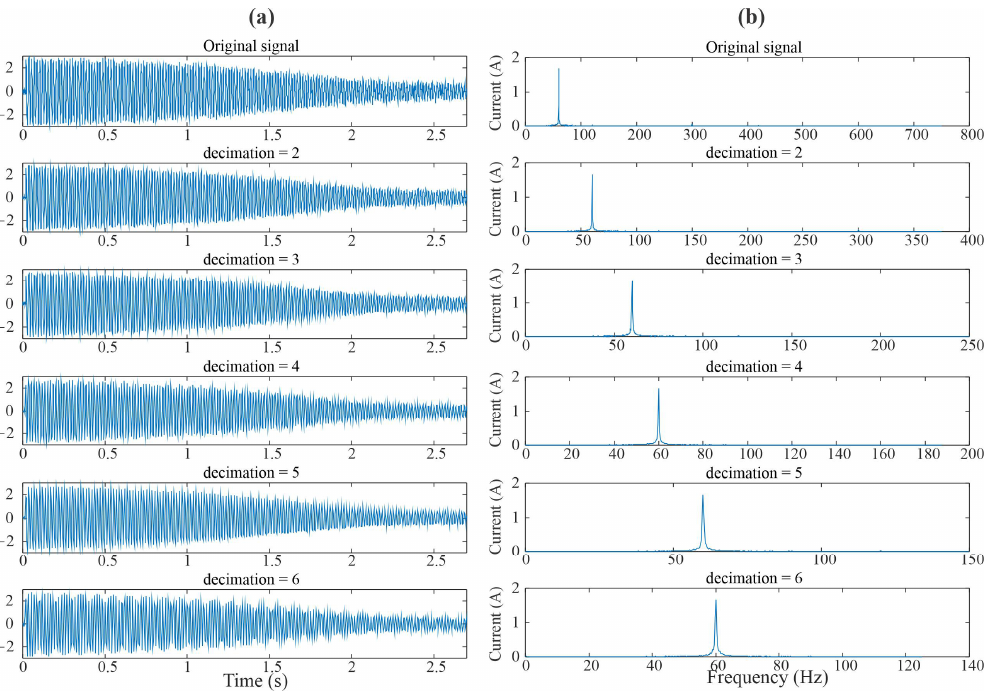
Figure 8. ( a ) Original and decimated current signals obtained using the steady-state regime and ( b ) their spectrums estimated by Fourier transform.